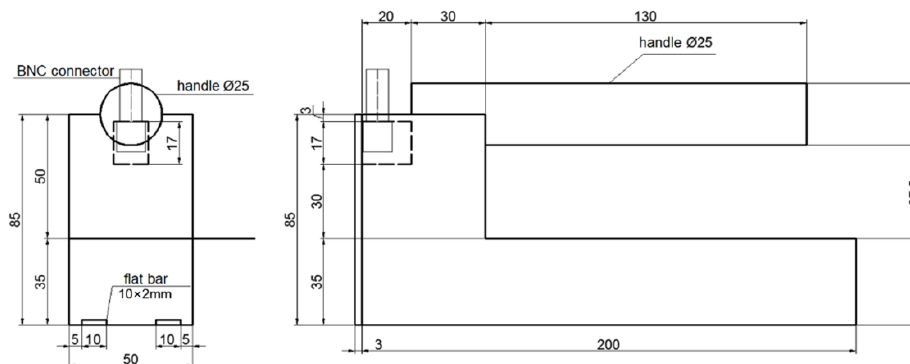
Figure 1. Sensor A design [18].